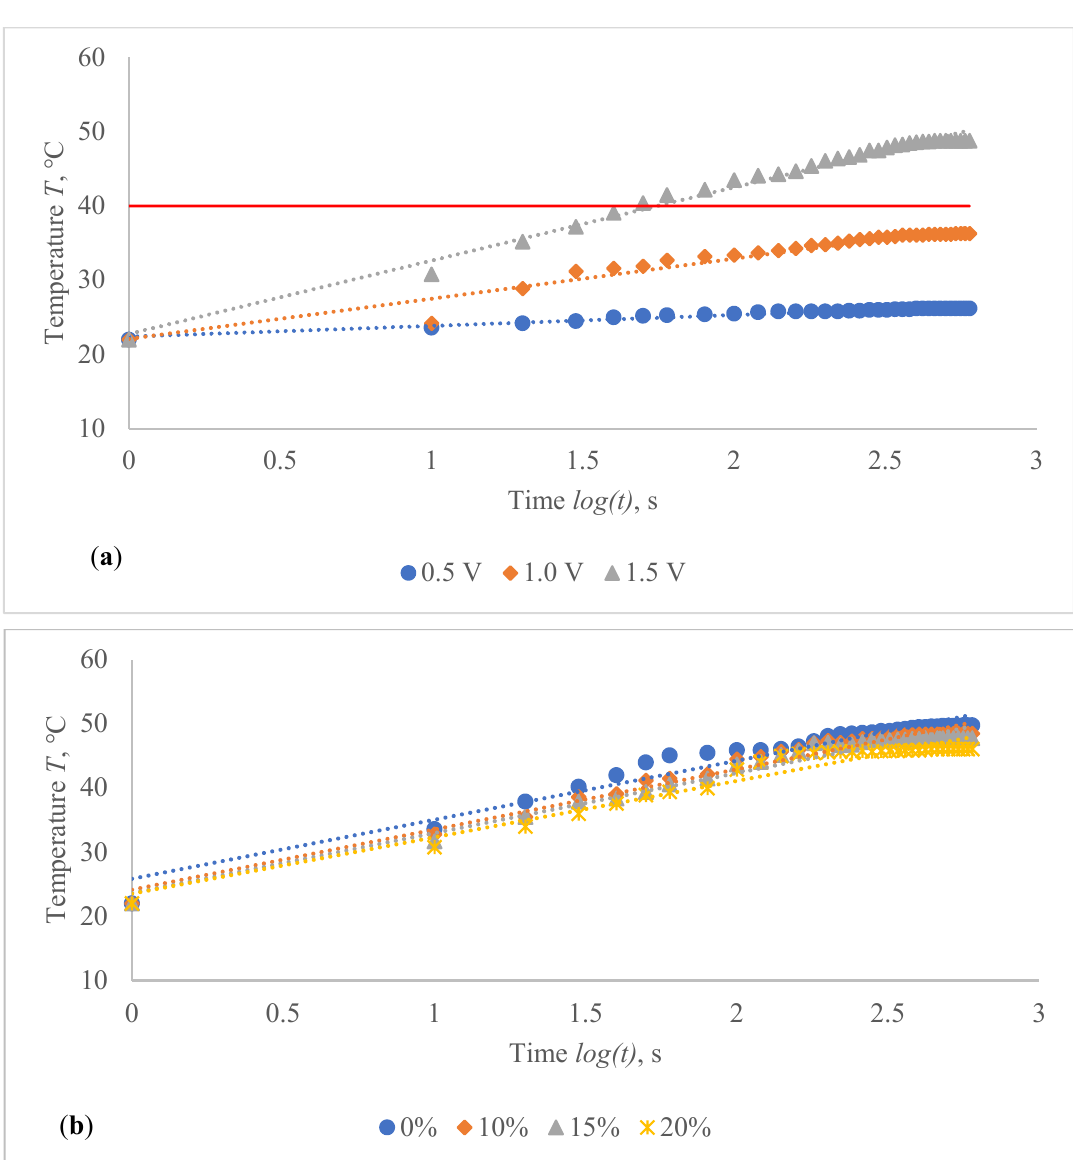
Figure 12. Temperature changes of CF_LY3 structured electro-conductive composite fabric during the 600 s period: ( a ) at non-stretched state by applying different voltage; and ( b ) at the different stretch levels by applying 2.5 V.